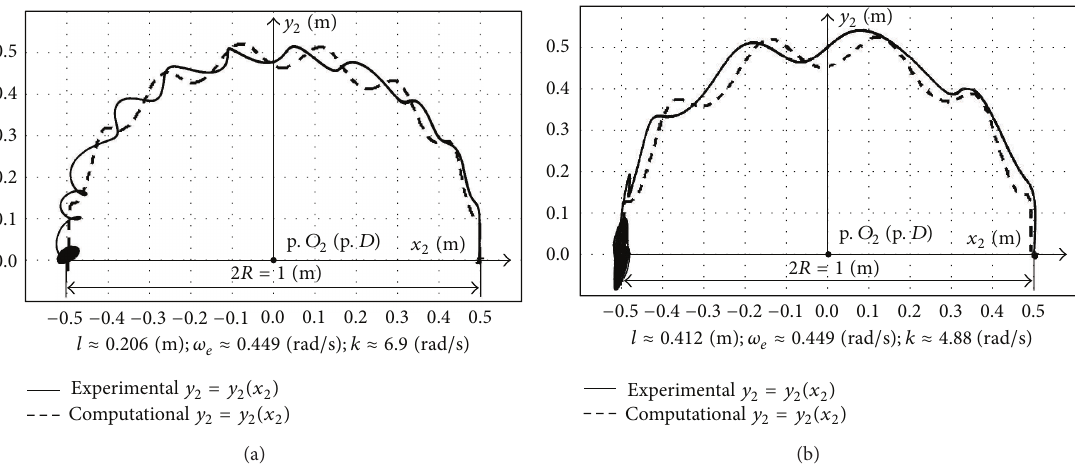
Figure 4: The comparison of the small swaying angle 𝛼 1 theoretical (- - -, 𝑦 2 = 𝑦 2 ( 𝑥 2 )) and experimental (—, 𝑦 2 = 𝑦 2 ( 𝑥 2 )) load absolute trajectories in the inertial reference frame E for fixed cable length 𝑙 = 0.206 m (a) and fixed cable length 𝑙 = 0.412 m (b).